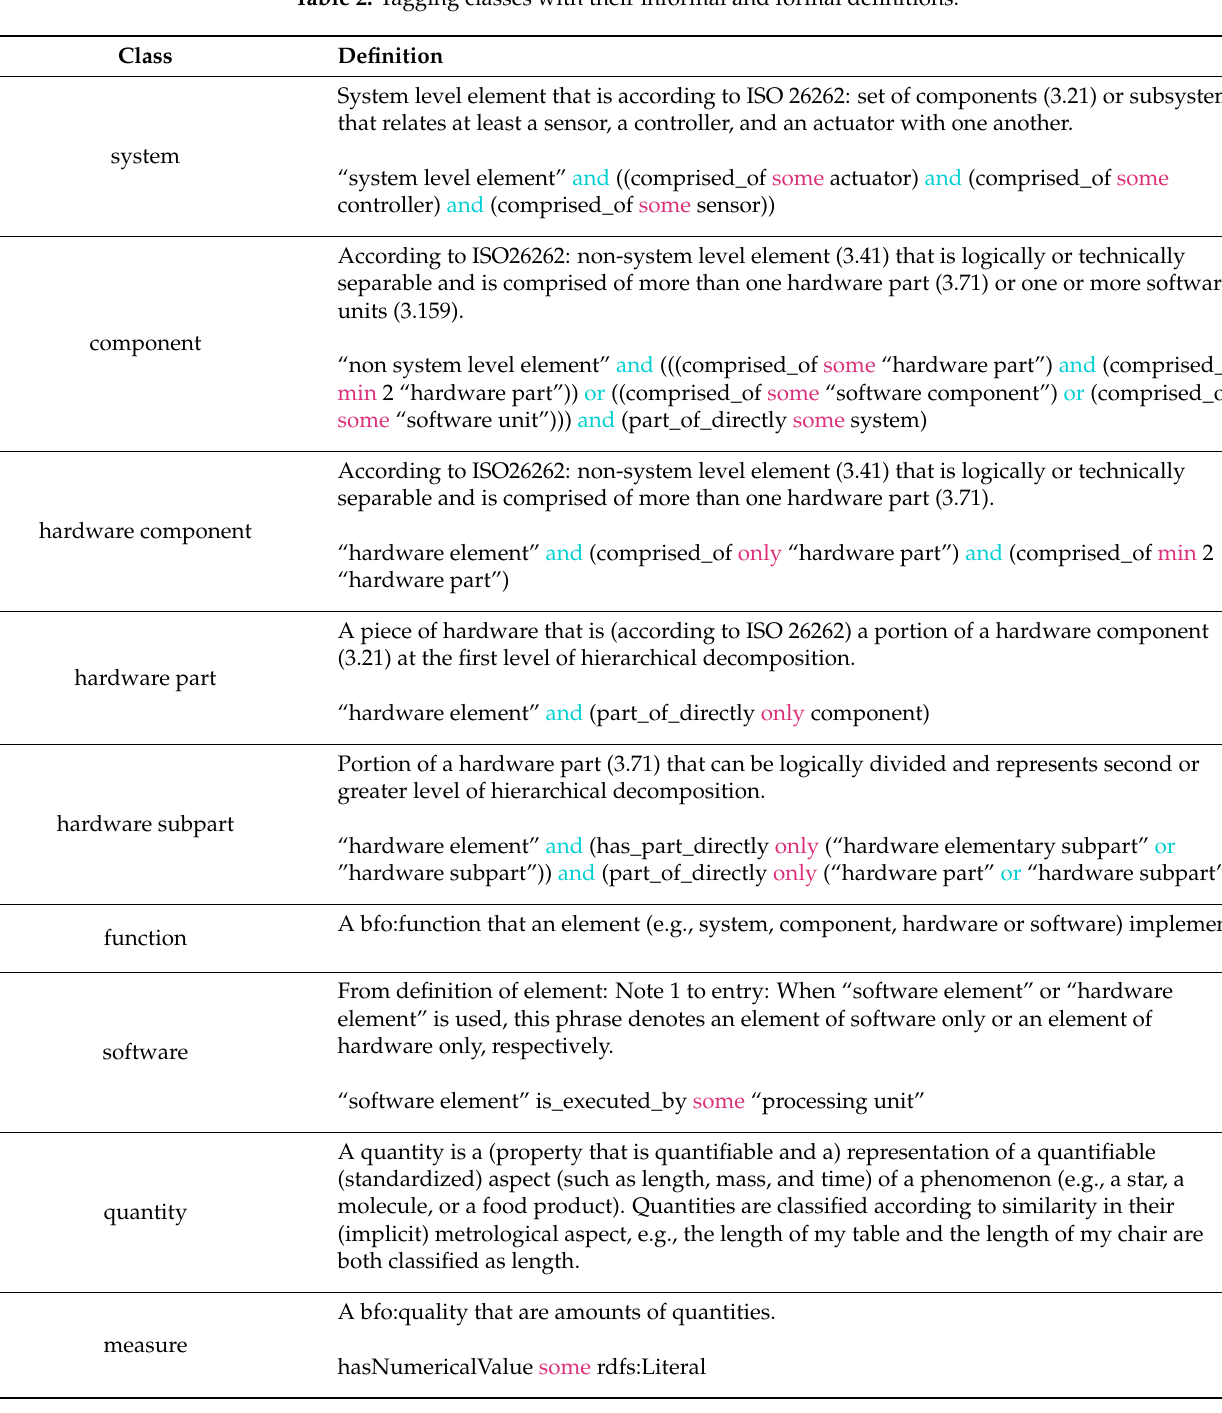
Table 2. Tagging classes with their informal and formal